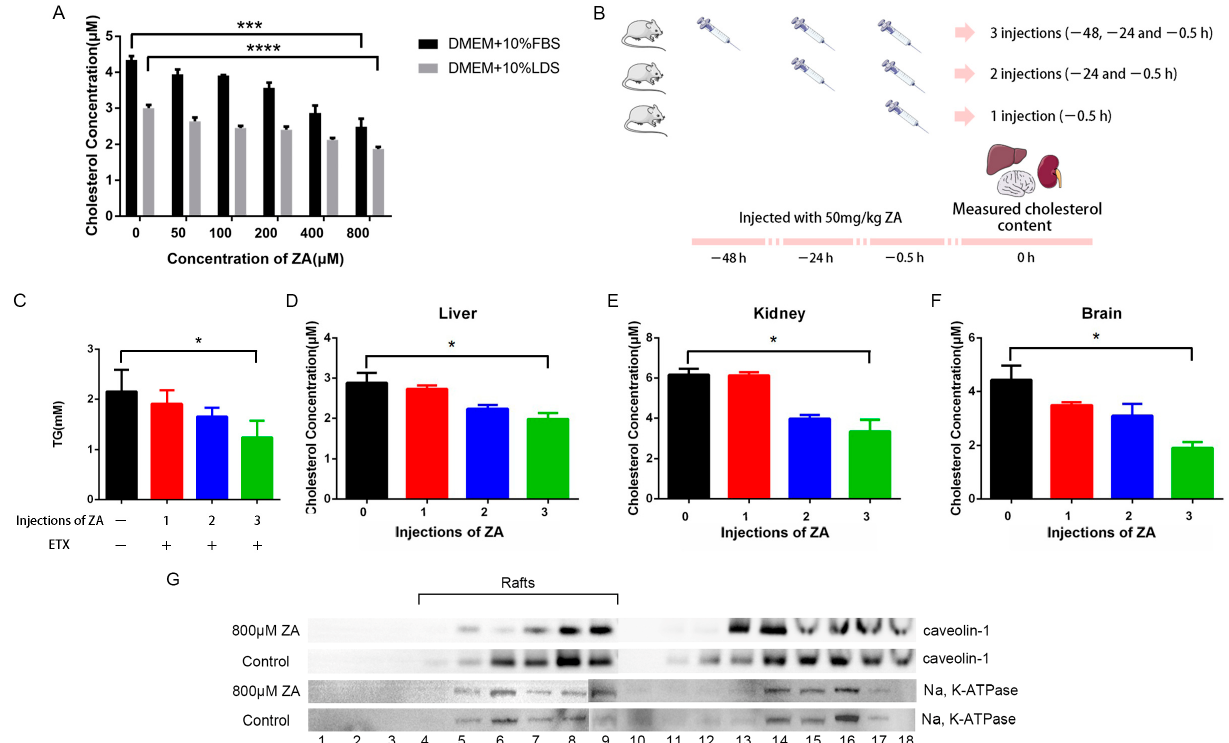
Figure 7. ZA inhibits the synthesis of cholesterol. ( A ) The cholesterol of MDCK cells incubated with ZA for 30 min was measured according to the manufacturer’s instructions using the Amplex red cholesterol assay kit. ( B ) Mice were injected with 50 mg/kg/day ZA for 3 injections ( − 48, − 24, and − 0.5 h), 2 injections ( − 24 and − 0.5 h), or 1 injection ( − 0.5 h) only. ( C ) Triglyceride (TG) levels of blood and cholesterol levels of liver ( D ), kidney ( E ), and brain ( F ) in different groups. ( G ) MDCK cells were incubated with ZA for 30 min, then collected, and the density gradient centrifugation and Western blotting were conducted. * p <0.05, *** p <0.001 and **** p <0.0001.